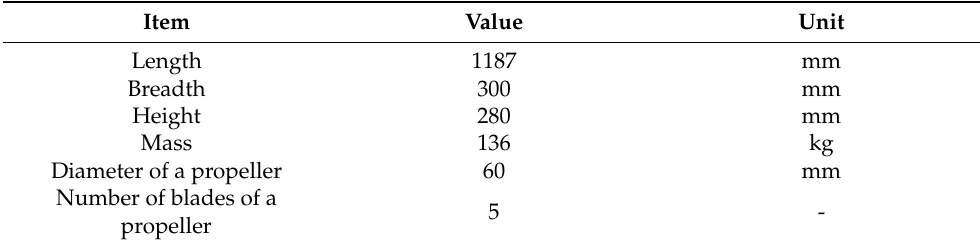
Figure 3. Principal dimensions of the Quadmaran vessel. Table 1. Principal particular of a single hull of the Quadmaran vessel.